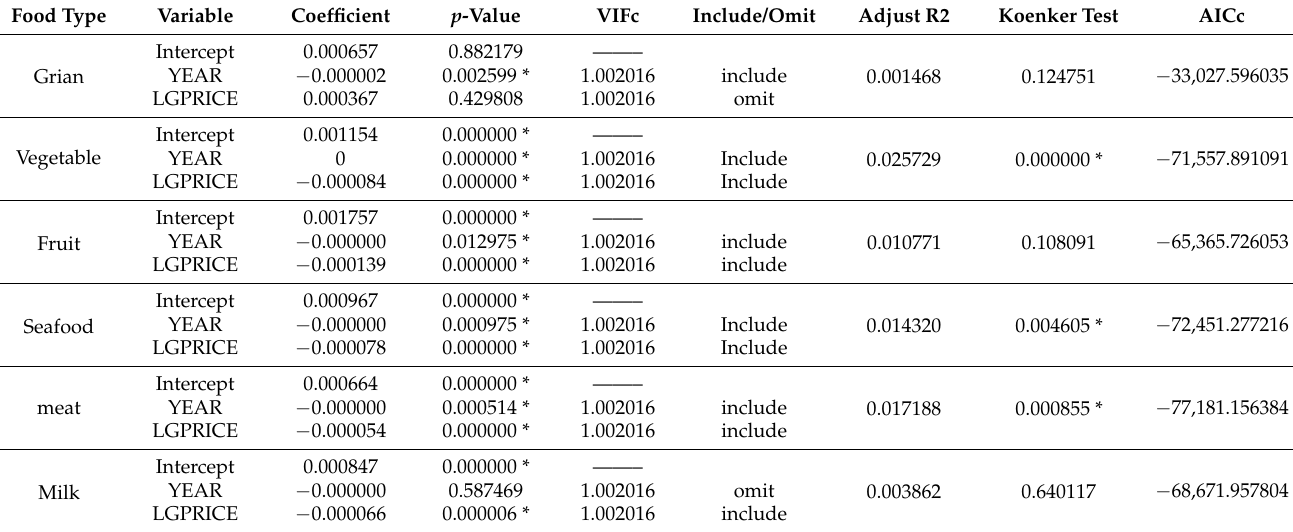
Table 2. The results of ordinary least squares (OLS) regression analysis.